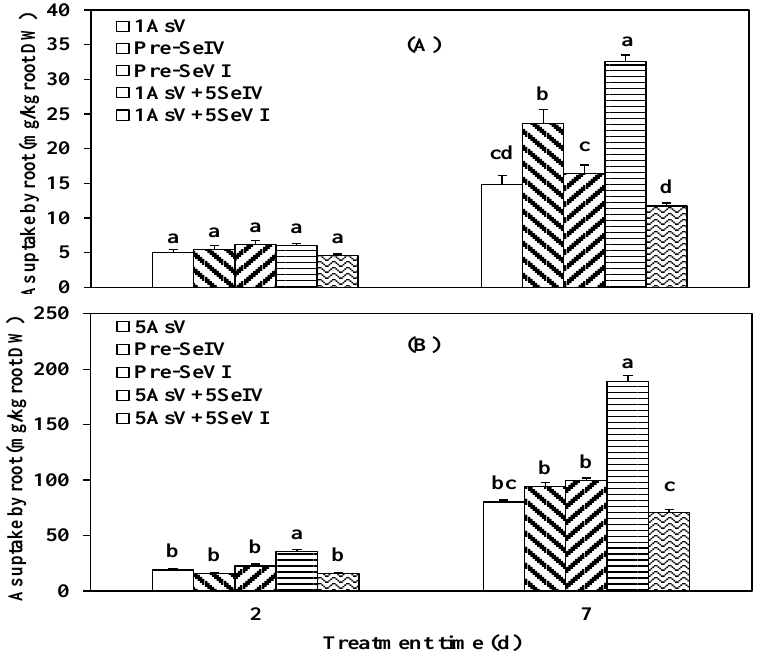
Figure 4. E ff ect of Se pretreatments and co-application on As absorption by rice treated to low ( A ) and high ( B ) As(V) concentrations. Data are the mean value ± SE (n = 3). The letters demonstrate statistically significant ( p < 0.05) di ff erences among